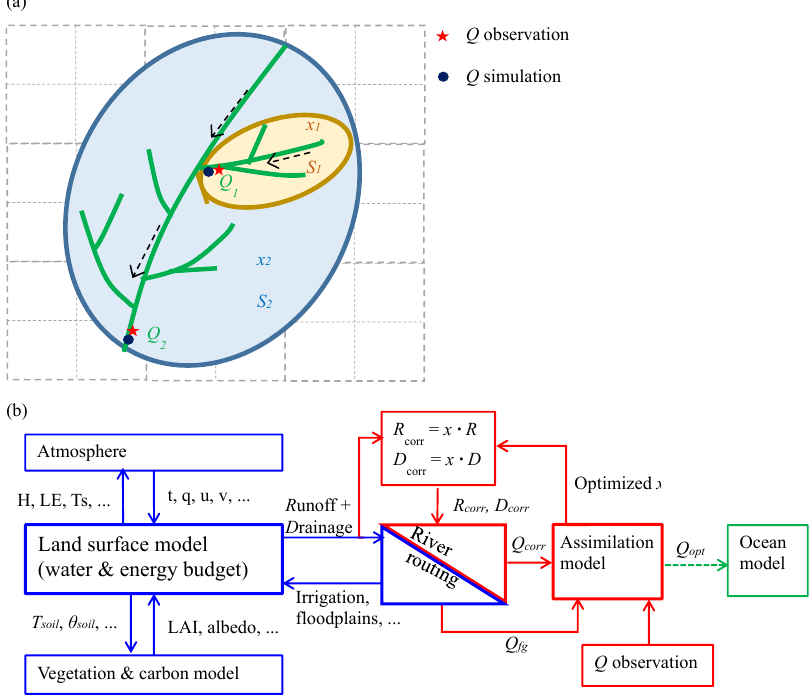
Figure 1. (a) Illustration of correcting river discharge ( Q) simulation (simulation in blue solid dot, observation in red star) by applying correction factors ( x) to runoff and drainage over different basins. Basin 1 and basin 2 are represented in yellow and blue, respectively. (b) The model framework of the river discharge assimilation. The blue and red parts are run for “First Guess” and for assimilation, respectively.